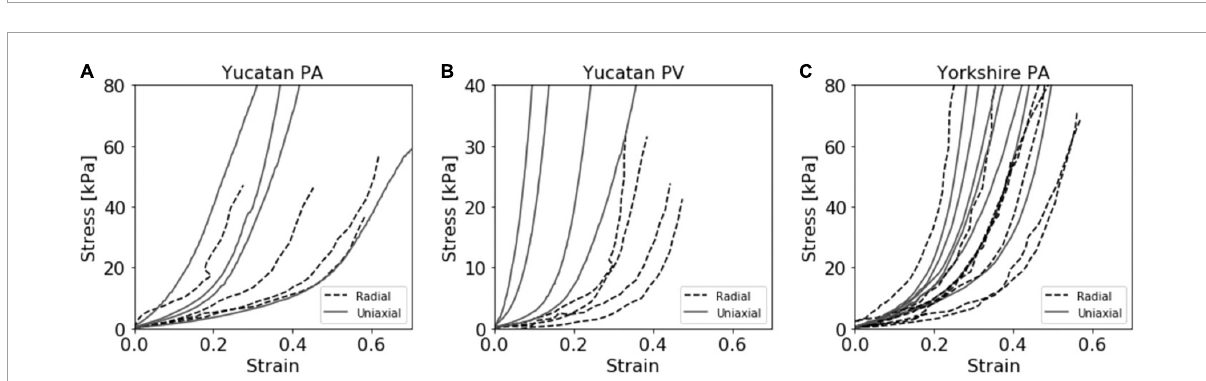
FIGURE3 Compiled stress vs. strain curves for both radial and uniaxial tensile testing methods for the (A) Yucatan pulmonary artery (PA), (B) Yucatan pulmonary valve (PV) region, and (C) Yorkshire PA tissue